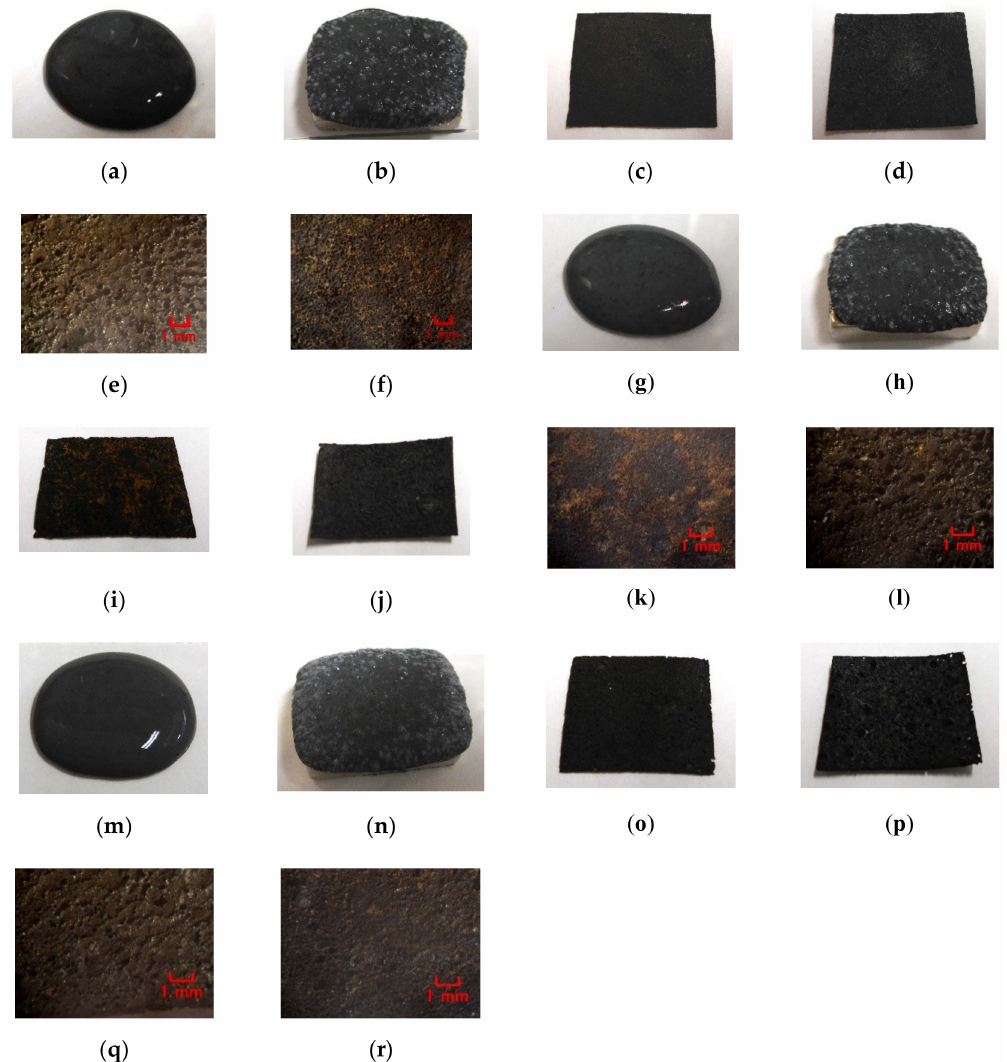
Figure 6. Images of liquid before electrolytic polymerization and mixing electrolytically polymerized rubber with water-insoluble liquid: ( a – f ) kerosene; ( g – l ) alkyl naphthalene; ( m – r ) para ffi n; ( a , g , m ) liquid before electrolytic polymerization without magnetic field; ( b , h , n ) liquid before electrolytic polymerization under magnetic field; ( c , i , o ) panoramic image of electrolytically polymerized rubber facing anode; ( d , j , p ) panoramic image of electrolytically polymerized rubber facing cathode; ( e , k , q ) microscopic image of electrolytically polymerized rubber facing anode by optical microscope; ( f , l , r ) microscopic image of electrolytically polymerized rubber facing cathode by optical